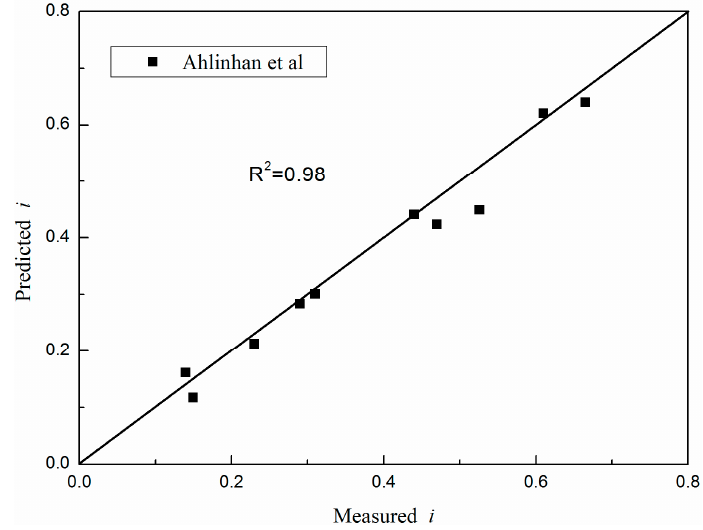
Figure 5. Comparison between predicted and measured data (Ahlinhan’s test).